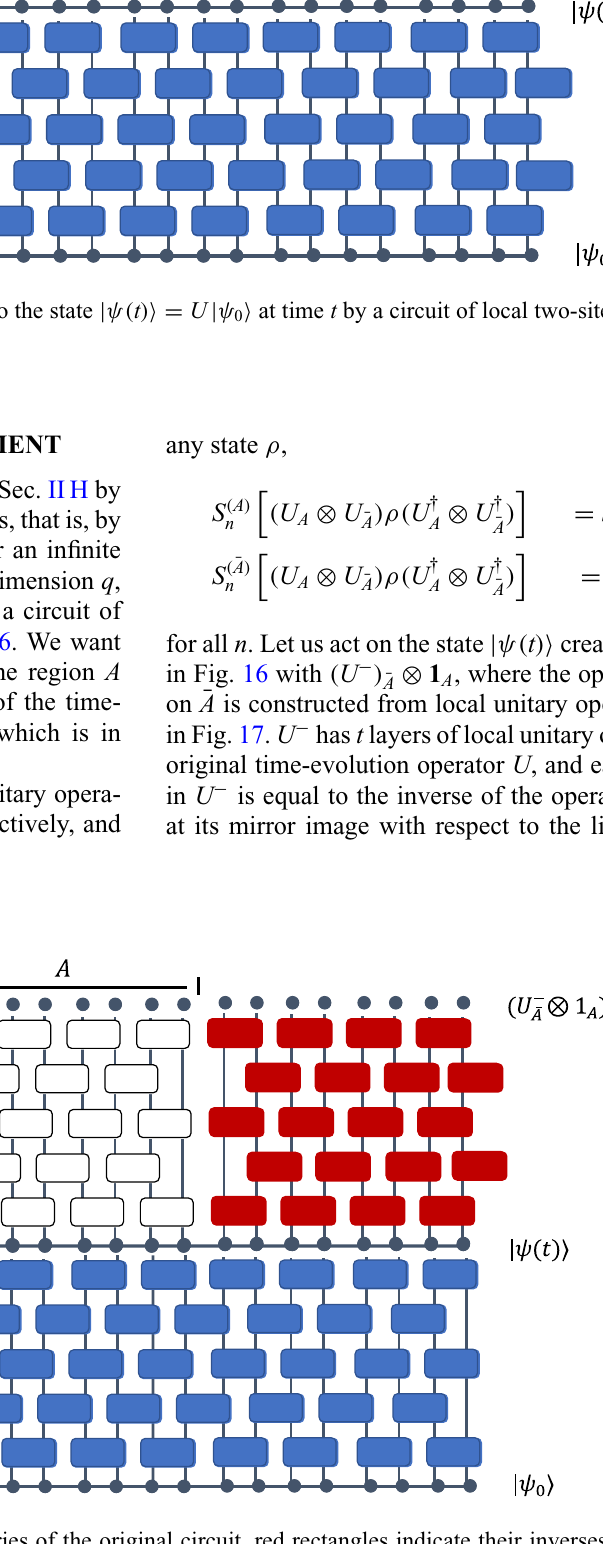
⊗ 1 | ψ( t ) (cid:2) , and some of the local random A on A